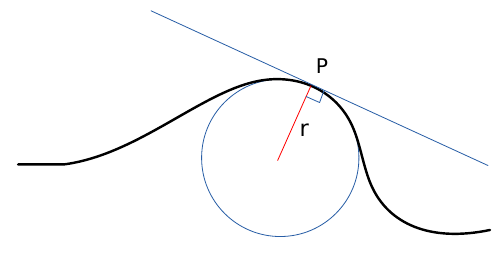
Figure 1: Curvature of a curve